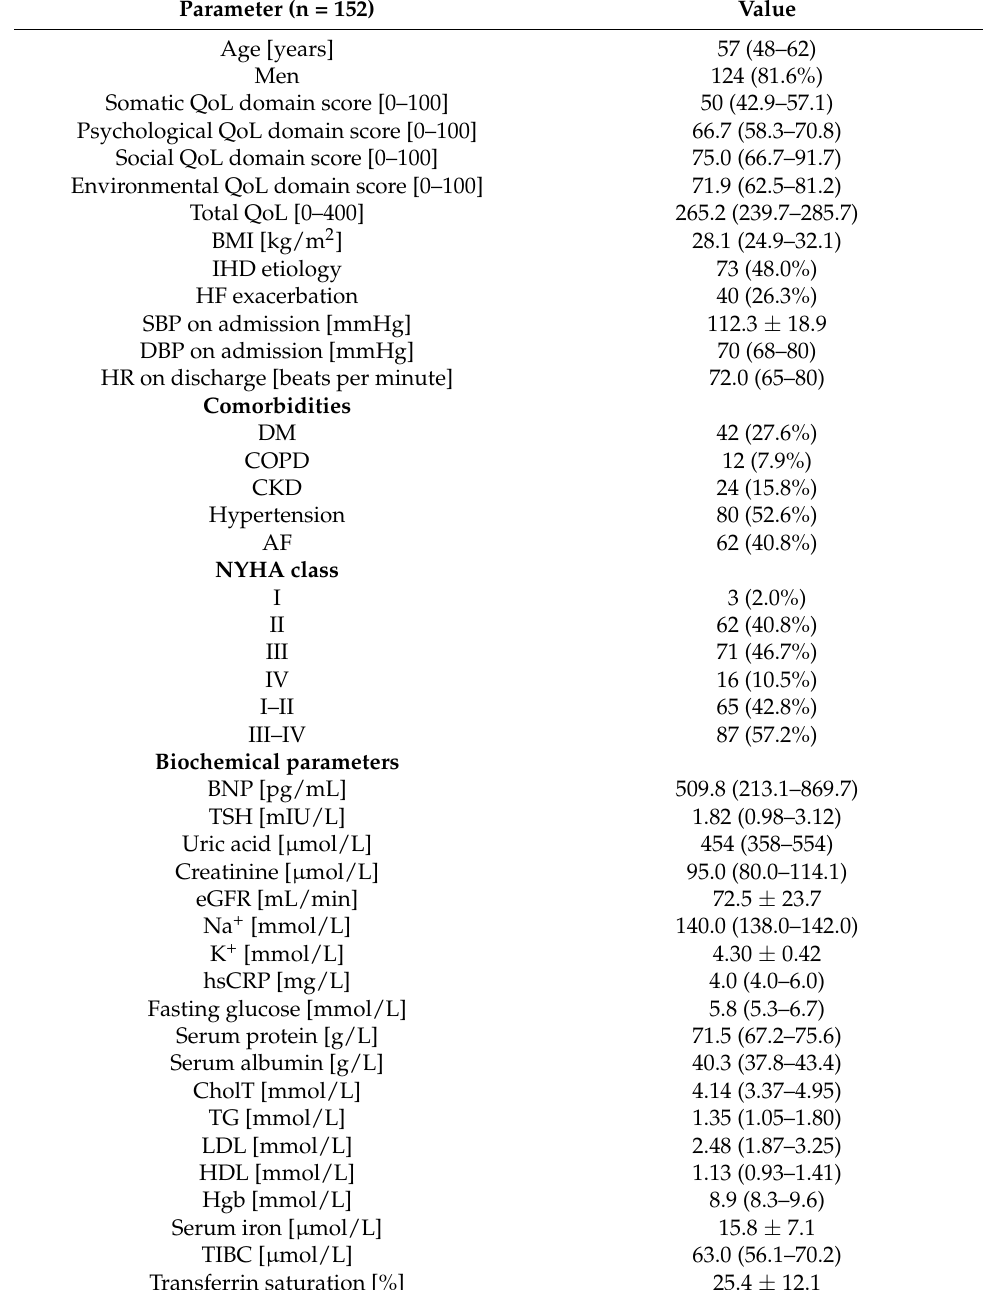
Table 1. Baseline characteristics of the study population (mean values and standard deviation, median and interquartile range or number and